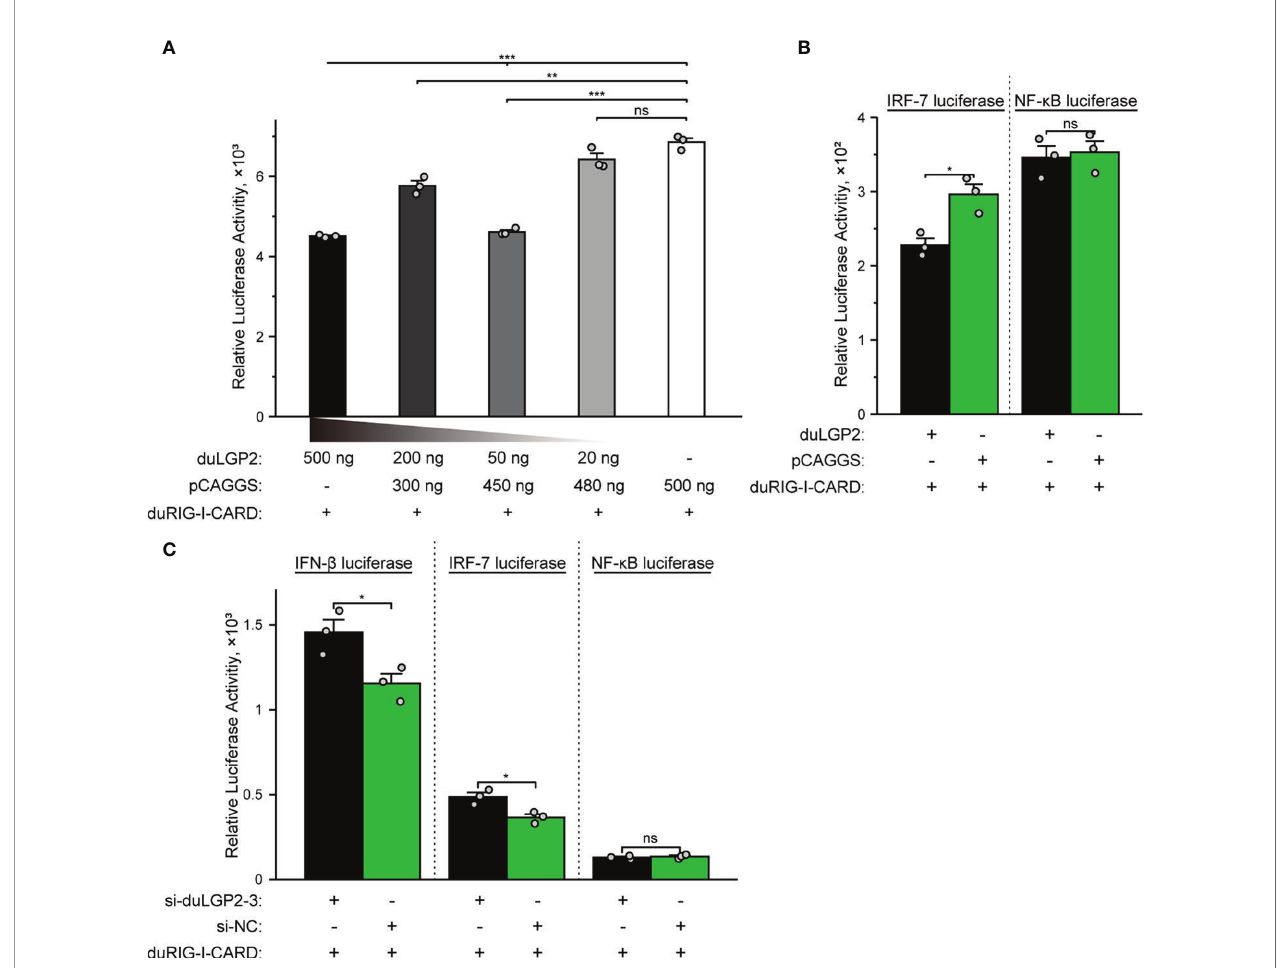
FIGURE 2 | duLGP2 regulates the duRIG-I-mediated IFN- b signaling pathway. (A) DEF cells were transiently co-transfected with the IFN- b promoter construct and indicated expression plasmids or empty plasmids pCAGGS. (B) DEF cells were transiently co-transfected with plasmids IRF-7 or NF- k B promoter construct with indicated expression plasmids or empty plasmids pCAGGS. (C) DEF cells were transiently transfected with siduLGP2-3 or si-NC, and the cells were transfected with indicated plasmids 24h after transfection with siRNAs. Cell samples were lysed at 24 hpt, and luciferase activities were quanti fi ed by normalization with Renilla luciferase activity. All samples were analyzed in triplicate, and all data were expressed as means ± SEM. *Signi fi cant difference ( P < 0.05); **Highly signi fi cant difference ( P < 0.01); ***Extremely signi fi cant ( P < 0.001); ns, no signi fi cant